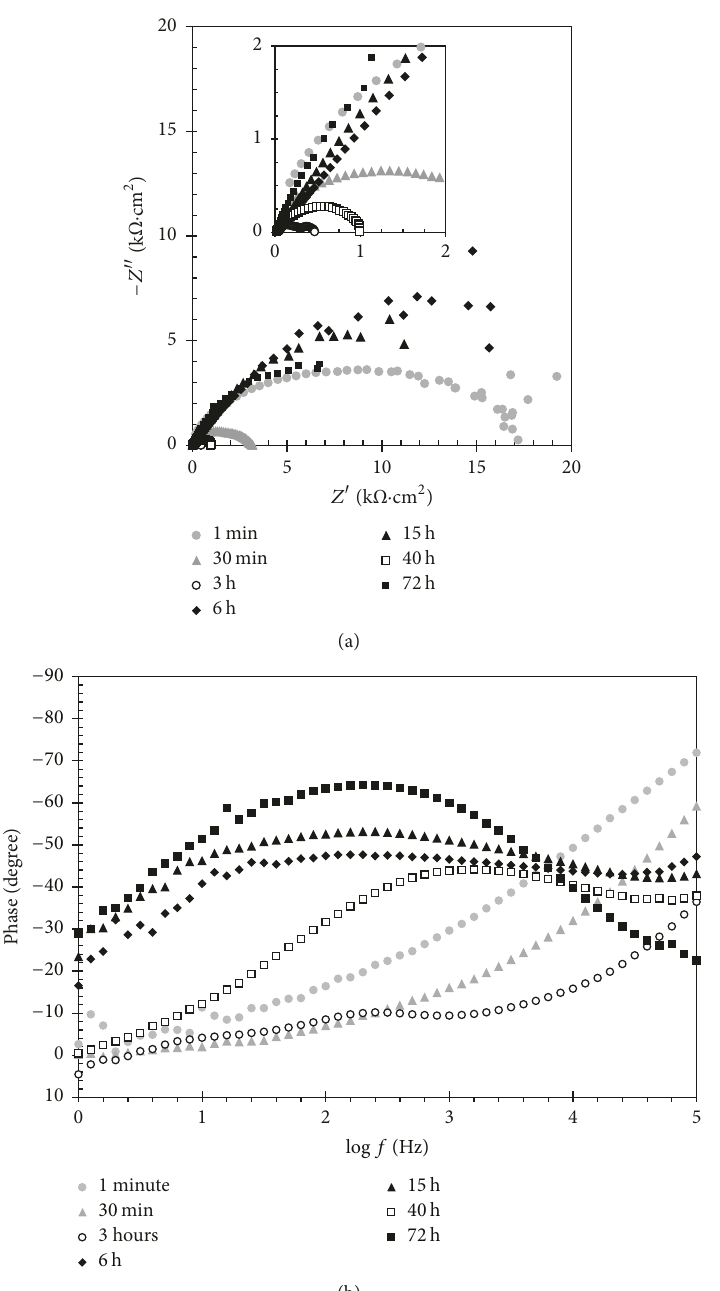
Figure 11: EIS diagrams of the AZ91D alloy immersed in 3.5 wt.% NaCl solution at room temperature for different times: (a) Nyquist and (b) Bode (phase angle versus log 𝑓 )